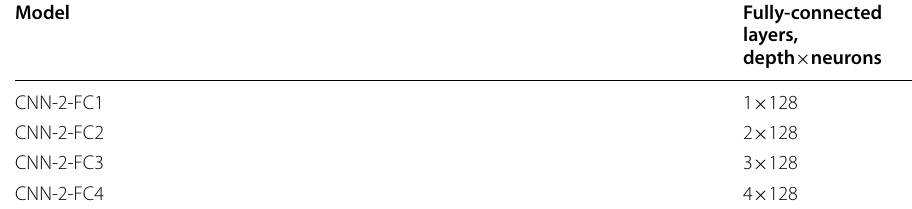
Table 5 Variation of CNN‑2 with different numbers of fully‑connected layers Model Fully‑connected